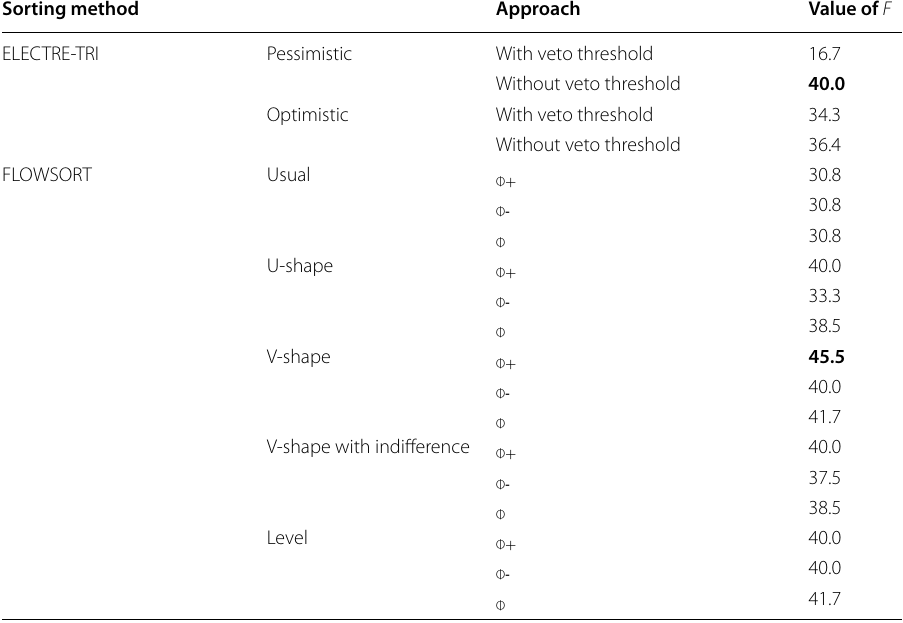
Best values are in bold